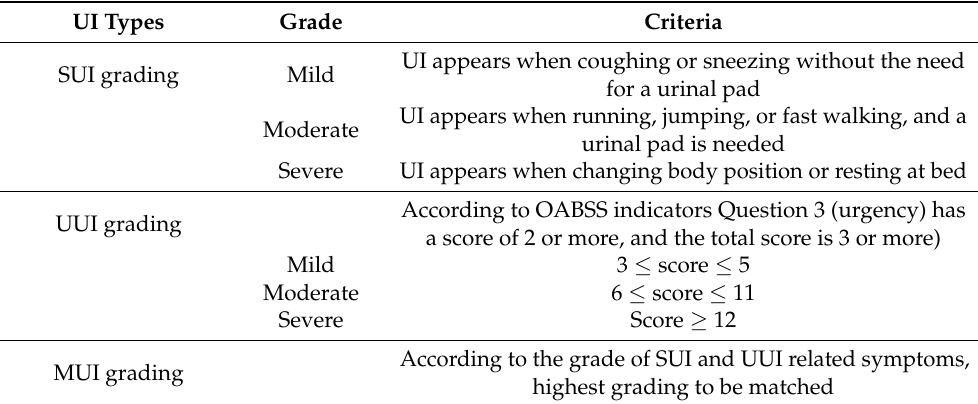
Table 1. Diagnosis criteria for subtypes of